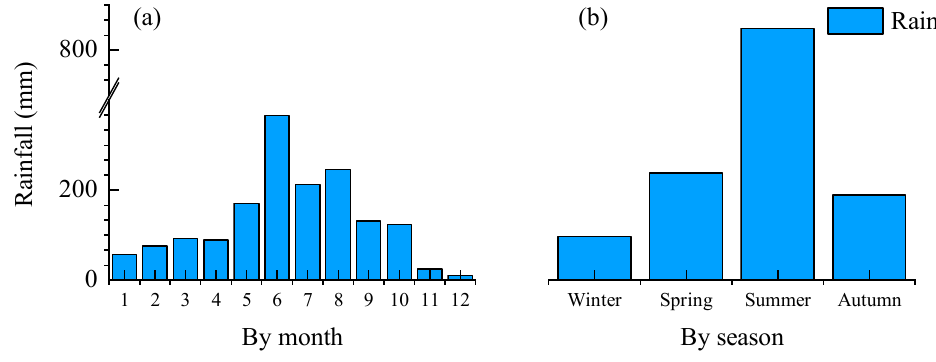
Figure 3. Accumulated precipitation by month ( a ) and by season ( b ).